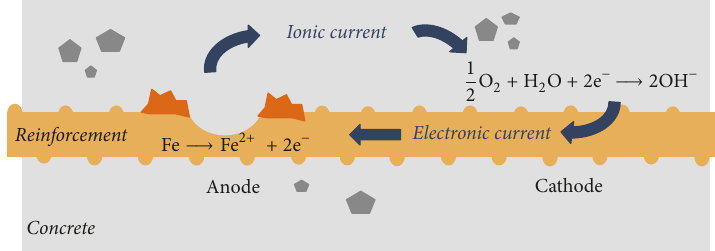
Figure 5: Process of embedded steel reinforcement providing an example of ionic flow in concrete [13].